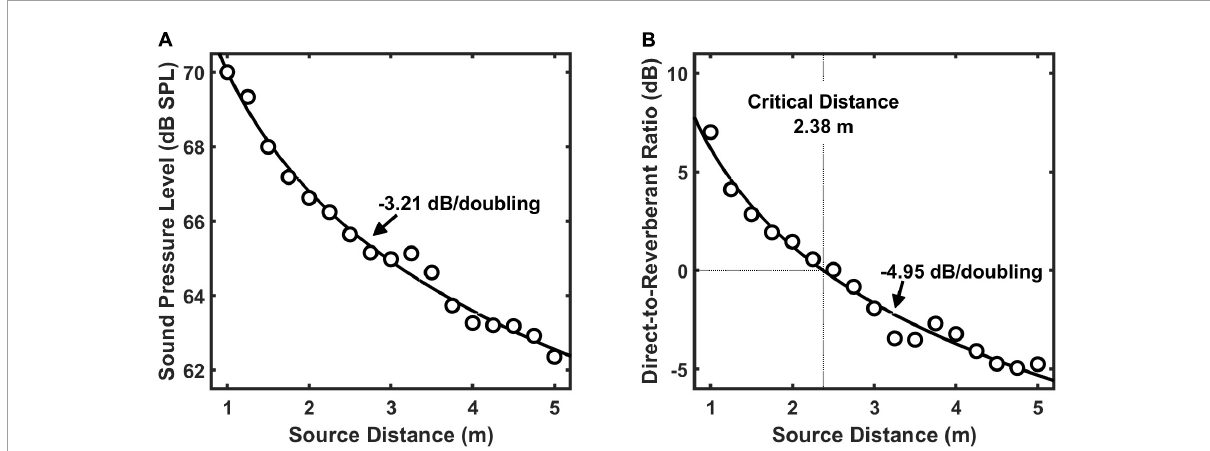
FIGURE3 Broadband sound pressure level (A) and direct-to-reverberant energy ratio (B) for the test stimulus as a function of sound source distance in the test environment. For each acoustic cue, functions were fit to the data to describe the decibel (dB) loss of that cue per doubling of source distance. The critical distance for the test environment, which is the distance at which direct and reverberant energies are equal, was 2.38 m.